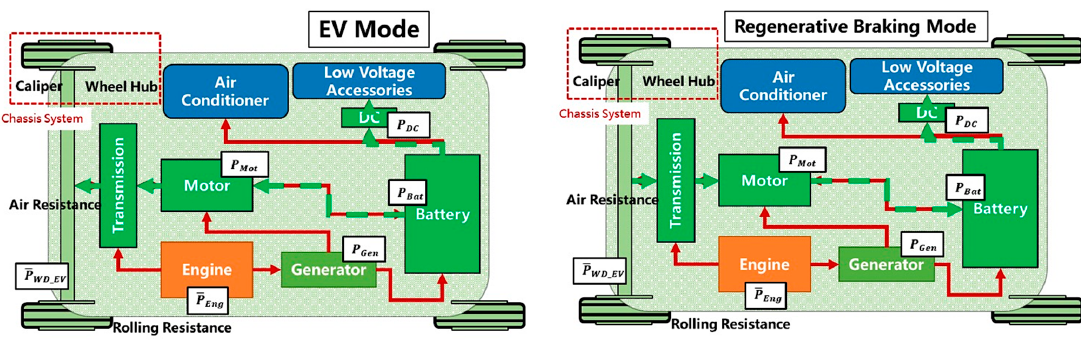
Figure 2. DMi EV